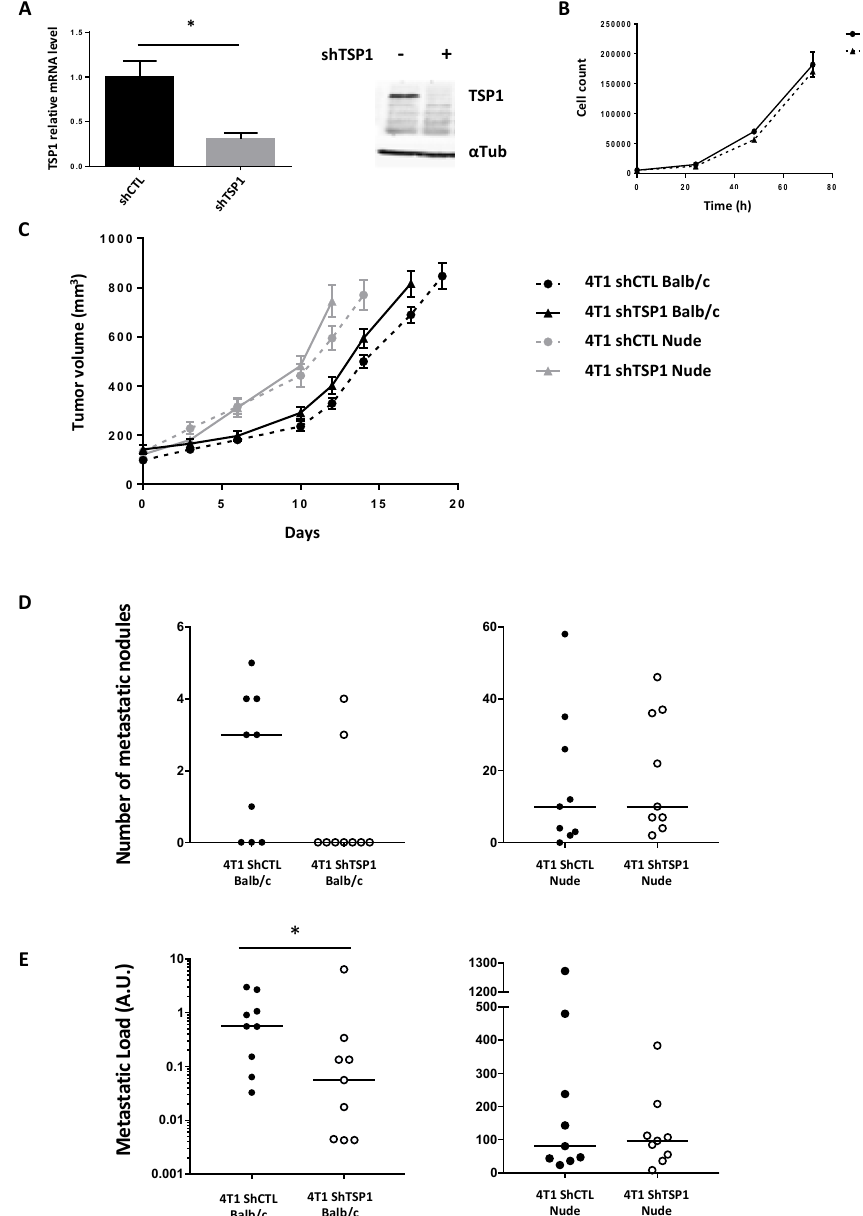
Figure 3 . Impact of TSP1 expression in 4T1 mouse breast cancer model. ( A ) TSP1 mRNA (left panel) and protein (right panel) expression in 4T1 shCTL and 4T1 shTSP1 was evaluated by RT-qPCR and Western blot, respectively. Left panel, data are means ± SEM of n = 3 independent experiments. ( B ) In vitro cell proliferation of 4T1 shCTL and 4T1 shTSP1, data are means ± SEM of triplicate determination of one representative experiment of three independent experiments. ( C ) Growth of 4T1 shCTL and 4T1 shTSP1 orthotopic tumors over time in Balb-c mice (black) and nude mice (gray). ( D , E ) Lungs were collected from 9 mice of each group (left panels: wild-type mice; right panels: nude mice) when primary tumors reached 1000 mm 3 . Visible lung metastatic nodules on the lung surface were counted ( D ). Alternatively, RNA was extracted from lungs, and metastatic load in lungs was quantified by measurement of luciferase mRNA level normalized to cyclophilin A ( E ). Bars indicate the medians (*: p < 0.05) .